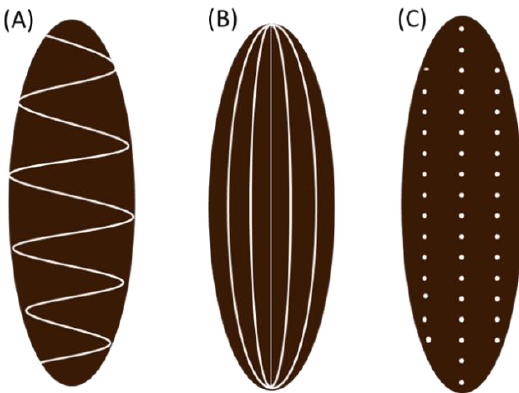
Figure 4. Incision patterns on cassava tubers for enzyme treatment. ( A ): spiral, ( B ): meridian, ( C ): perforation.